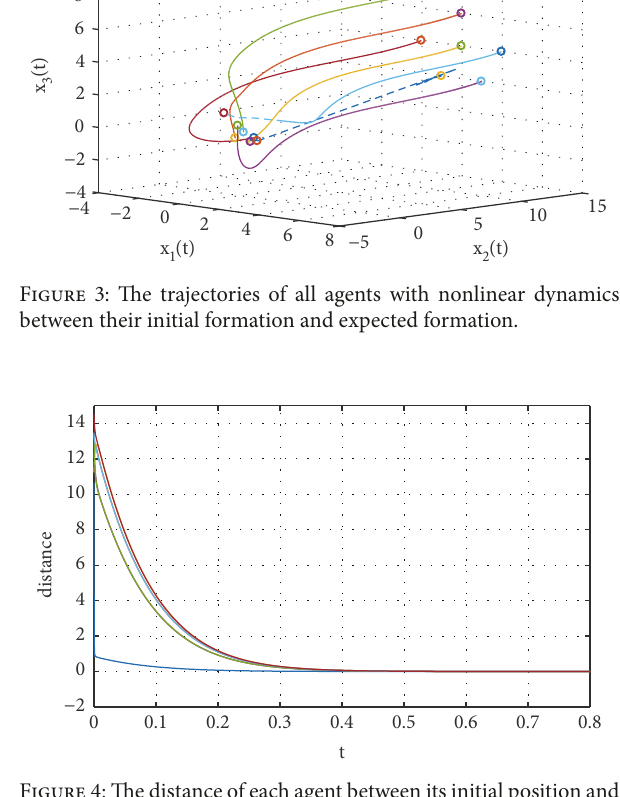
Figure 4: The distance of each agent between its initial position and expected